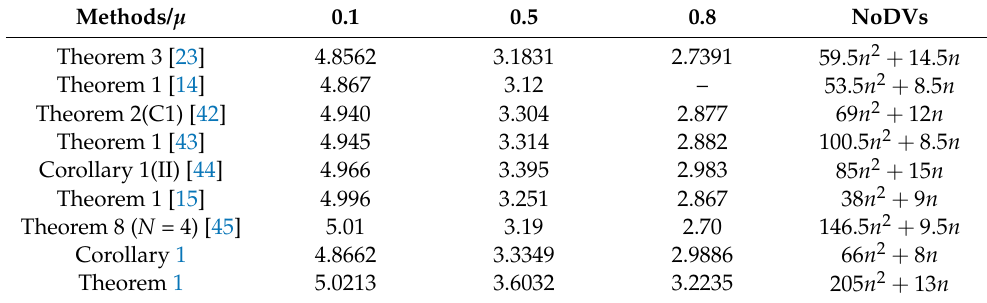
Table 1. The MDUB h for different µ in Ex1.